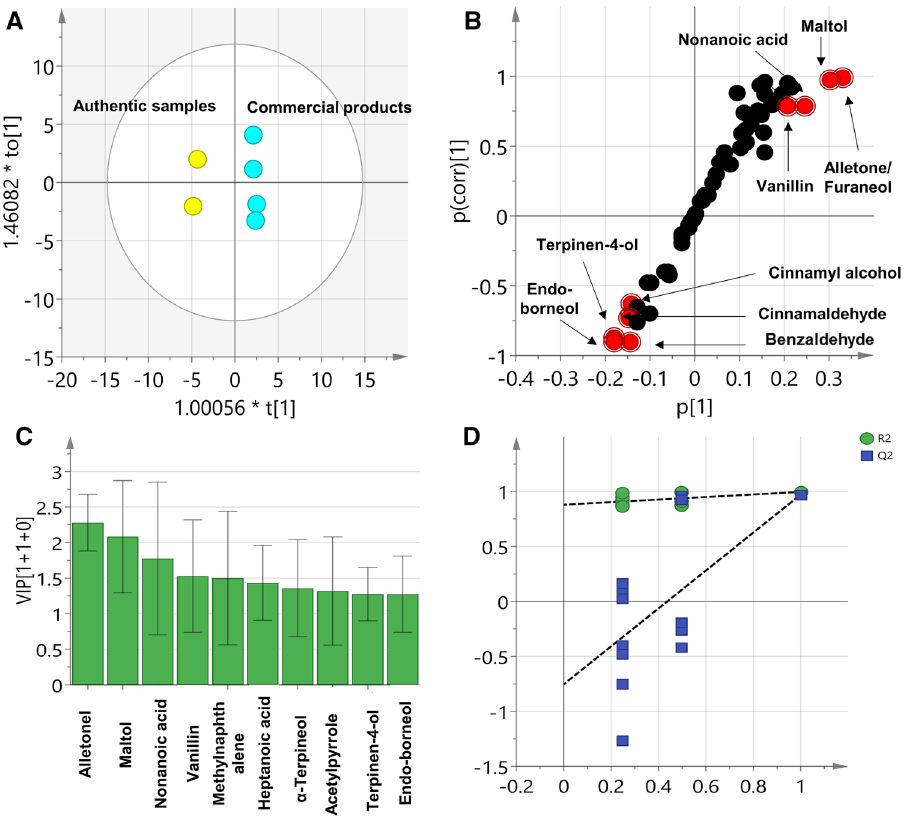
Figure 6. (A) OPLS-DA score plot and ( B) loading S-plots derived from E. longifolia authentic samples modelled against other commercial samples analysed by GC–MS . (C) top 10 variables that have the greatest influence on the projection as revealed from the developed OPLS-DA model. ( D) Permutation test (n = 200) as a validation criterion for the OPLS-DA model, the test verifies the validity of the model with negative intercept for the Q2